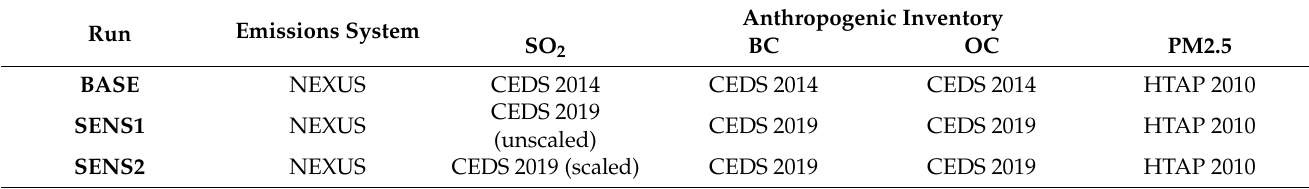
Table 1. Simulation set-ups with emissions